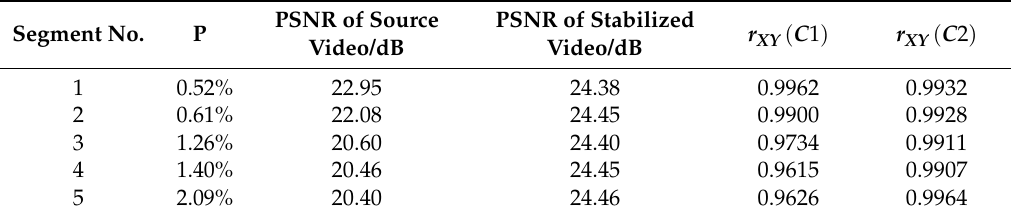
Table 1. PSNR values and the correlation coefficients for five segments of video.